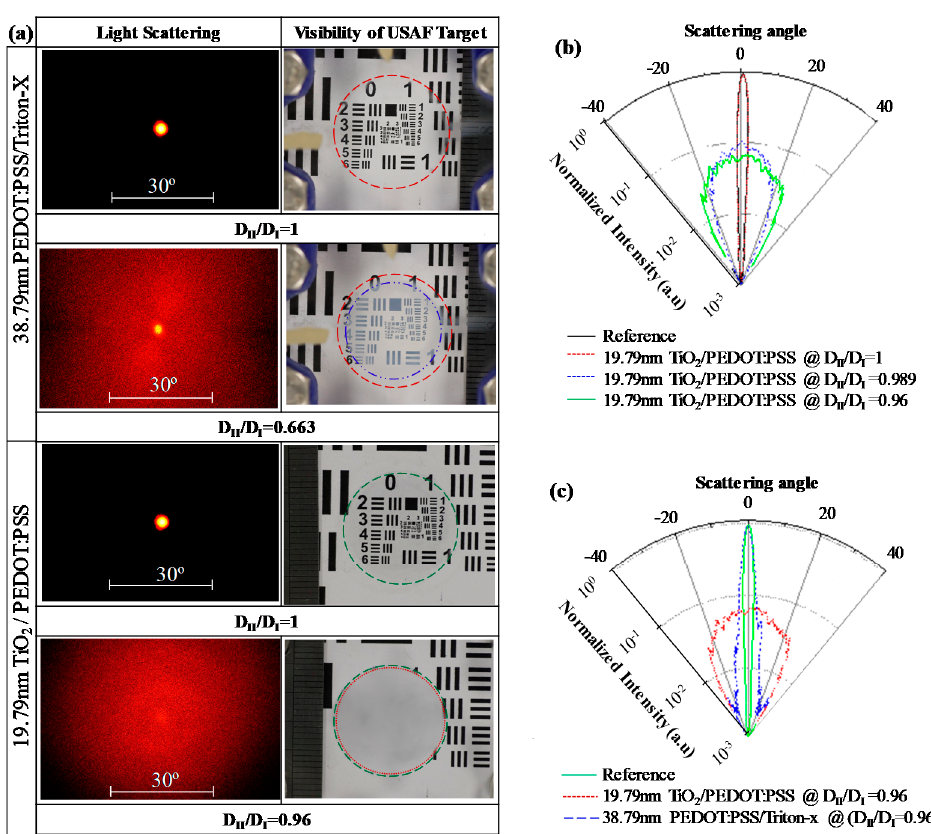
Figure 4. Scattering of normally incident laser beam and corresponding transparency of the devices: ( a ) image of laser spot through an unwrinkled device which is later scattered through the wrinkled surface; ( b ) angular light intensity distribution by the 19.79 nm TiO 2 and 38.79 nm PEDOT:PSS coated devices at different compression strain; ( c ) comparison of angular light intensity distribution between 19.79 nm TiO 2 /PEDOT:PSS and just PEDOT:PSS coated devices at same compression strain of 4%.